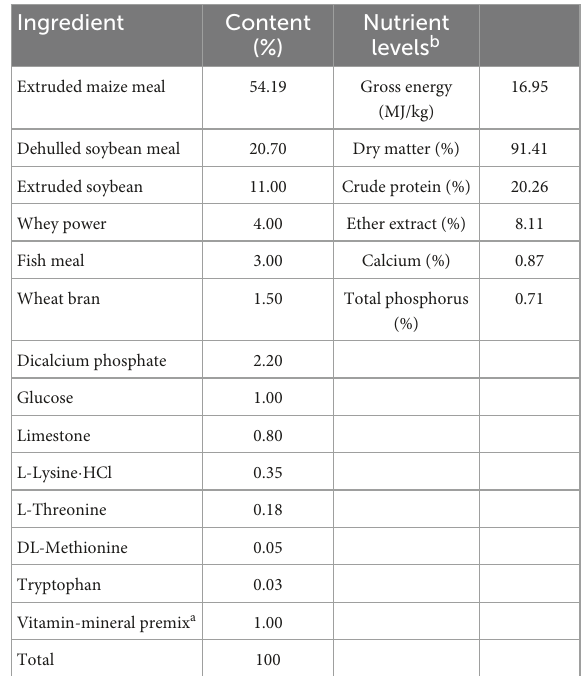
TABLE 1 The ingredient composition and nutrient content of diets (%, as-fed